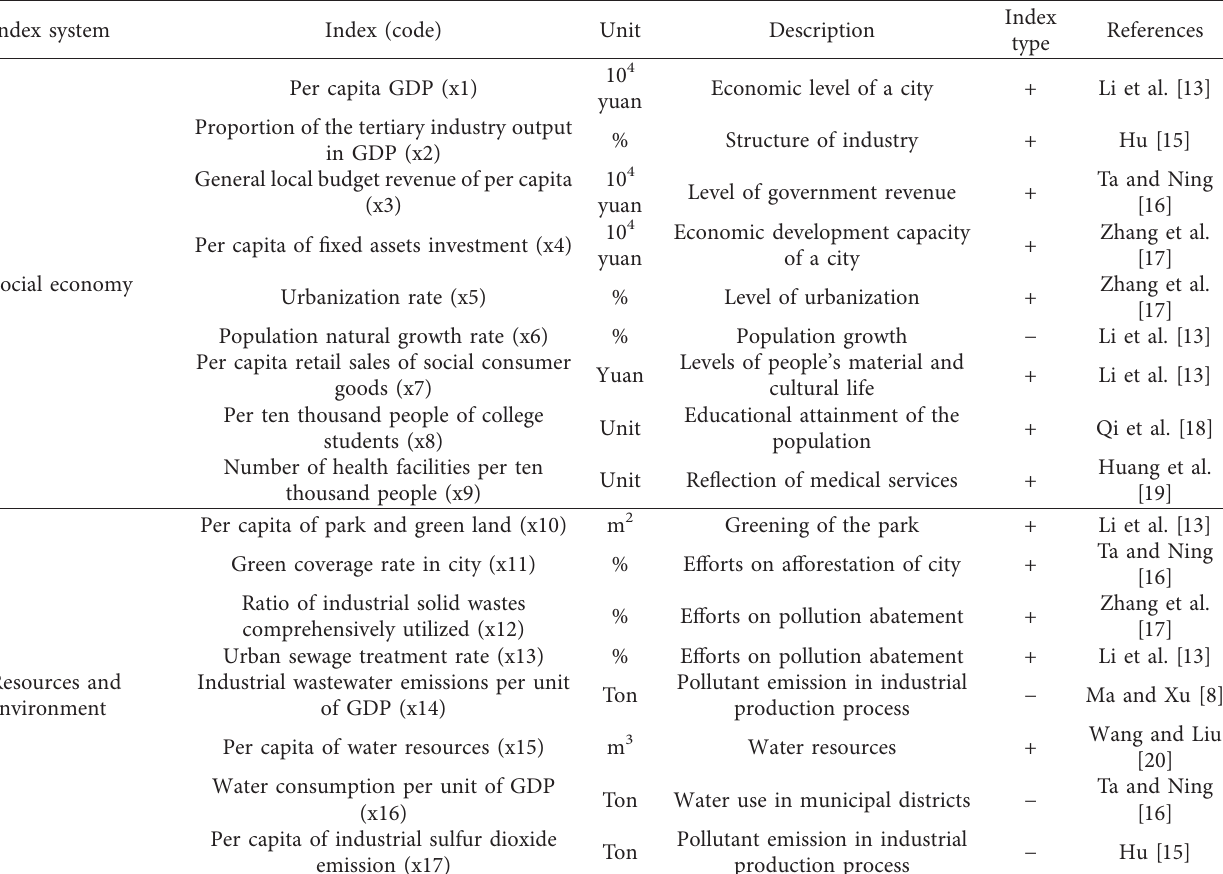
Figure 1: The research area of the central cities in the Yellow River Basin. Table 1: Index system of social economy and resources